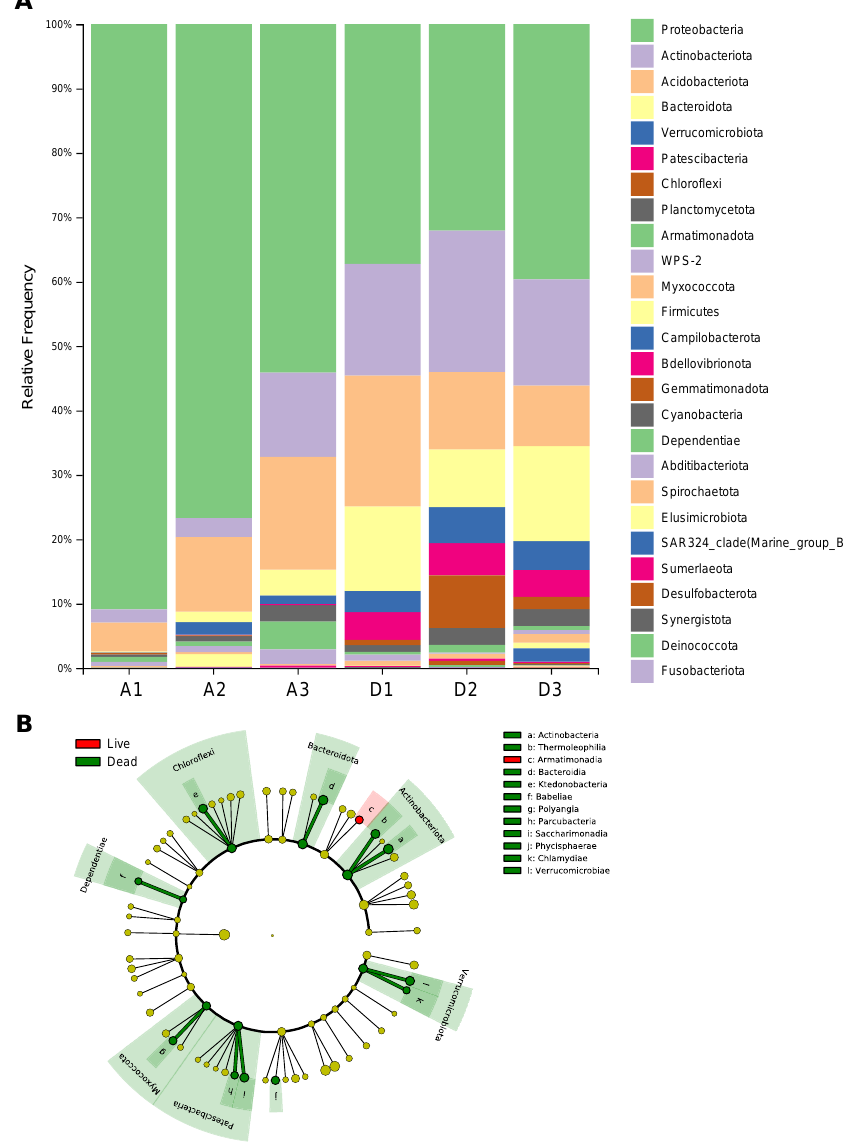
Figure 3. Abundance and taxonomic composition of the bacterial communities from live and dead Korean fir trees. ( A ) Relative abundances of bacterial phyla in live and dead trees. A1 to A3 and D1 to D3 indicate live and dead trees, respectively. ( B ) Cladogram representation of differentially abundant bacterial taxa between live and dead trees. Differentially abundant bacterial taxa were analyzed using LEfSe with linear discriminant analysis (LDA) score > 2.0 and a p < 0.05. Taxonomic level of phylum is labeled while class is